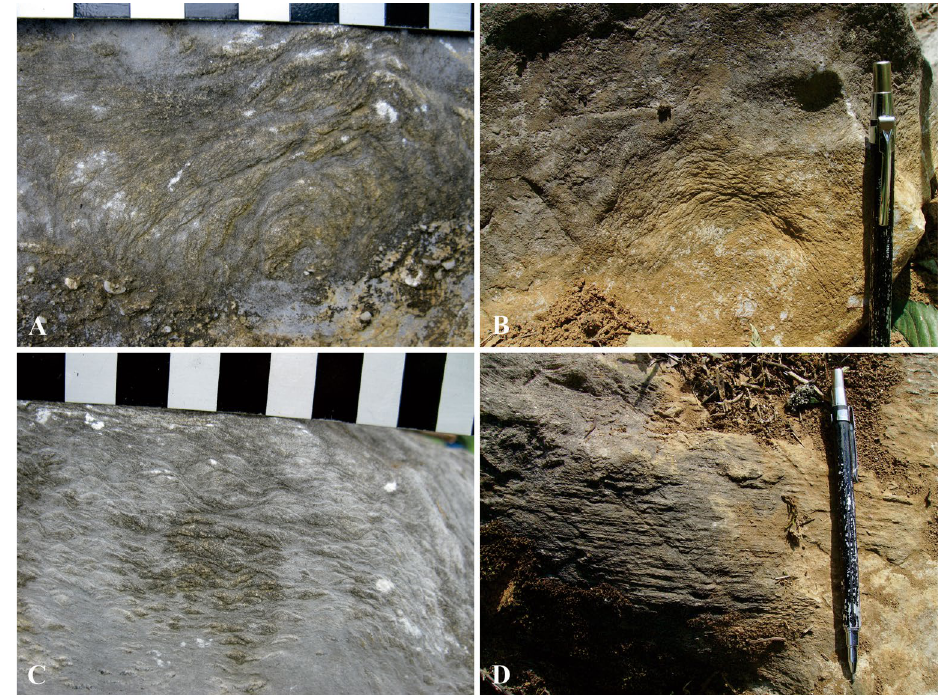
Figure 4. Algal bondstone in the Langping. Bondstone formed by various algaes living in still water. Morphology of bondstone correlates water environment and deposition of mud. Vast algal bondstones indicate deep water and high deposition rate. This figure is modified by the author from field photos with CorelDRAW (version 2022, and the URL link: https:// www. corel draw. com/ cn/).